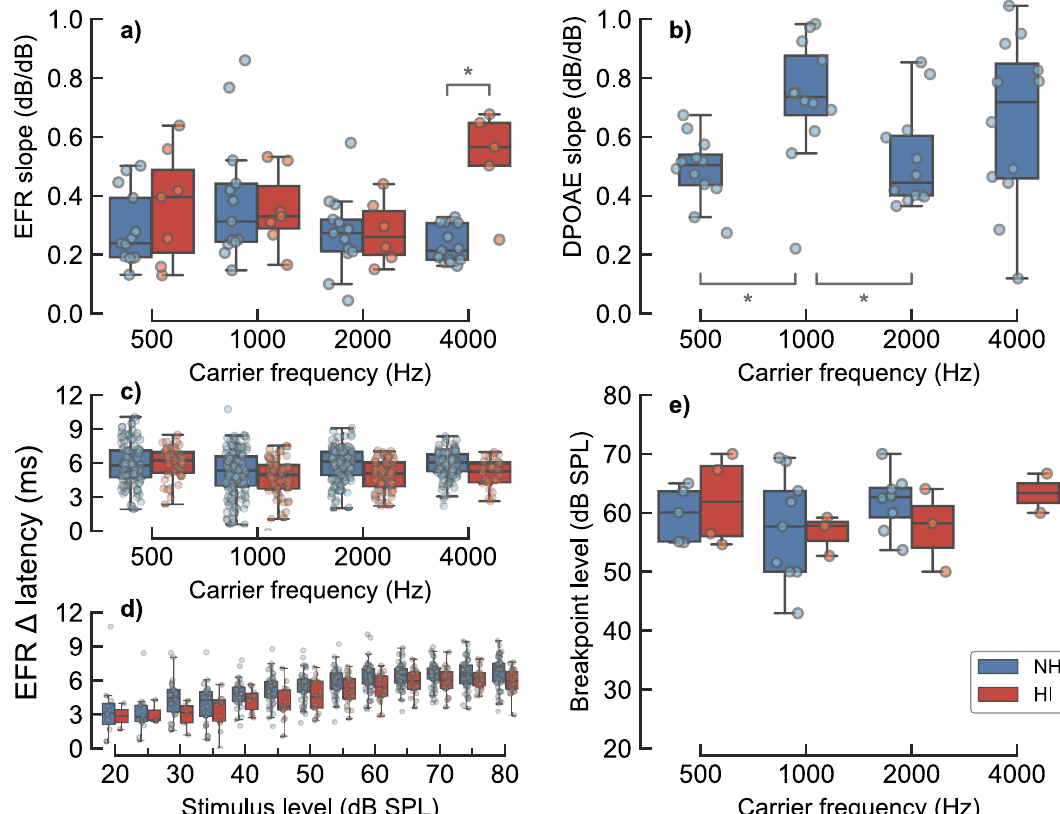
Figure 2. Group statistics of EFR and DPOAE data for NH and HI listeners. Panel ( a ) shows box-plots with the fitted EFR slopes obtained for each carrier frequencies in the NH (blue) and HI (red) listeners. Panel ( b ) shows box-plots with the fitted EFR slopes for same the NH listeners. Panels ( c , d ) show EFR latency increment (referenced to the shortest recorded latency) as a function of frequency and stimulus level, respectively. Panel ( e ) shows EFR break-point levels for the different carrier frequencies when the two-slopes piecewise fit was used. The bottom and the top of each box represent the first and third quartiles, respectively, and the horizontal line inside each box represents the second quartile (the median). Whiskers indicate 1.5 times the interquartile range (IQR) of the lower and upper quartiles. The circles depict the raw observations. Statistical significance, based on a two-sample permutation test for equality of the means, is represented by the asterisks, where * corresponds to p ≤ 0.05 .